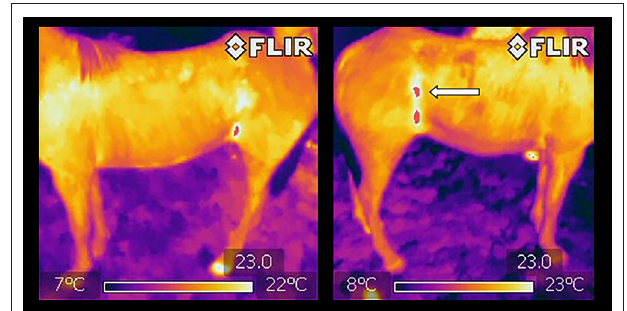
FIGURE 2 | Left lateral and right lateral digital thermography images of the same horse acquired at a distance of 5m to detect potential bruising. Arrow in the right lateral image shows an asymmetric high temperature zone (red “patch”) when compared to left lateral view.